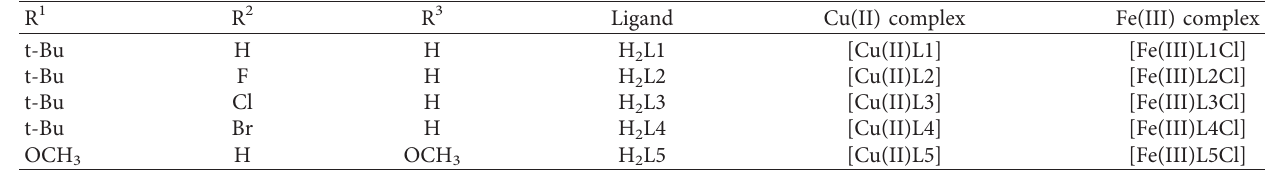
Table 2: Unsymmetrical tetradentate Schiff base ligands and their Cu(II) and Fe(III)